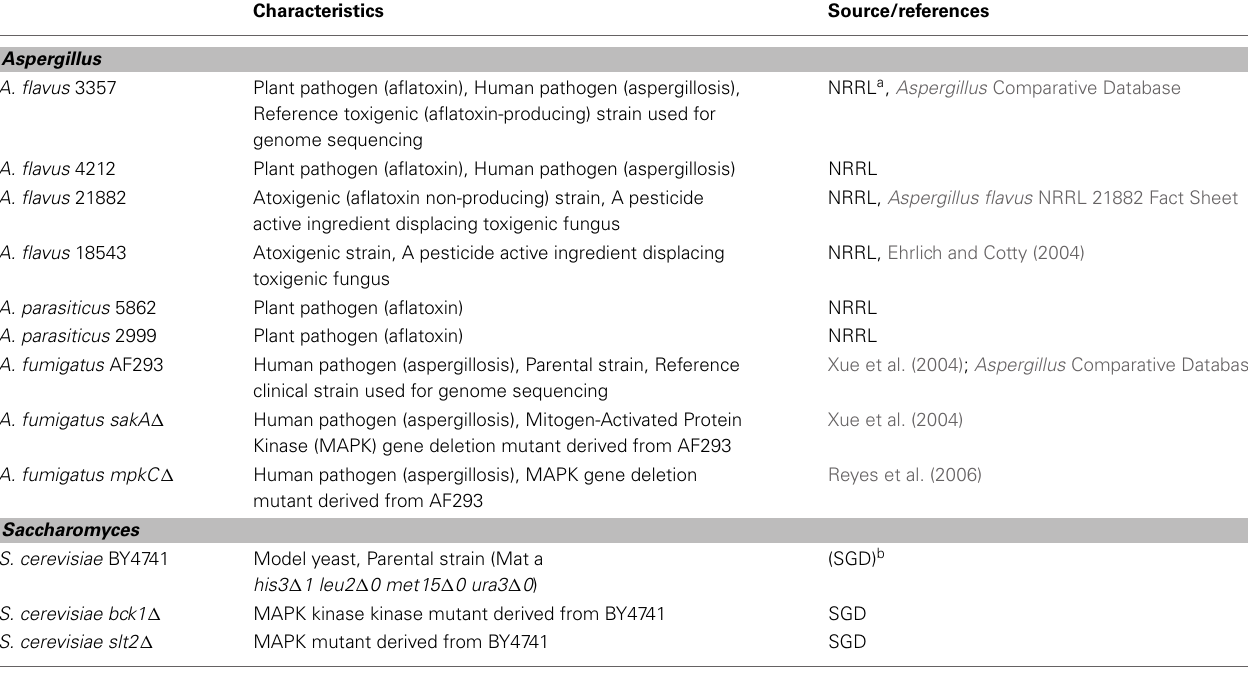
Table 1 | Microbial strains used in this study.